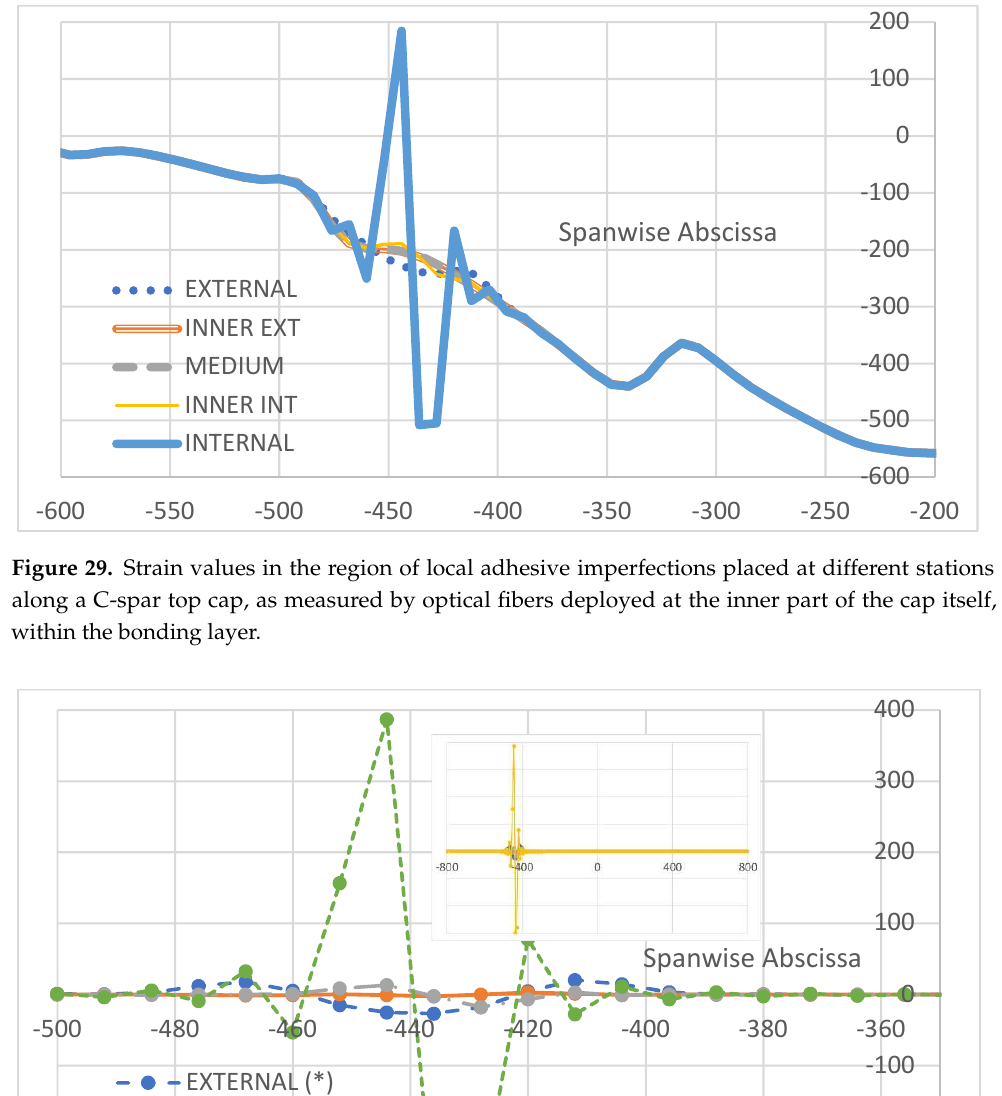
Figure 31. Histogram representation, in a logarithmic scale, of the strain difference, measured by the same optical fiber, as the flaw is moved from a side to the other of the cap. Reported values refer to four different abscissas, spanwise, in the region of the max difference (internal fiber, Figure 26). Values are referenced to those recorded in the case of a flaw placed at the middle of the cap (*). 10. Numerical–Experimental Correlation Experimental investigations were carried out on the composite beam introduced above. A specific test rig was implemented (Figure 32), made of steel tie rods and con- nected to a Newport Production self-leveling optical table via two I-section steel beams. The optical table was equipped with a network of M6 holes, 25 mm stepped, to anchor the different parts. At the top of the tie rods, a reinforced base hosting a HIWIN LAI-2 linear actuator was mounted. The actuator had a 30 cm stroke and was able to provide a